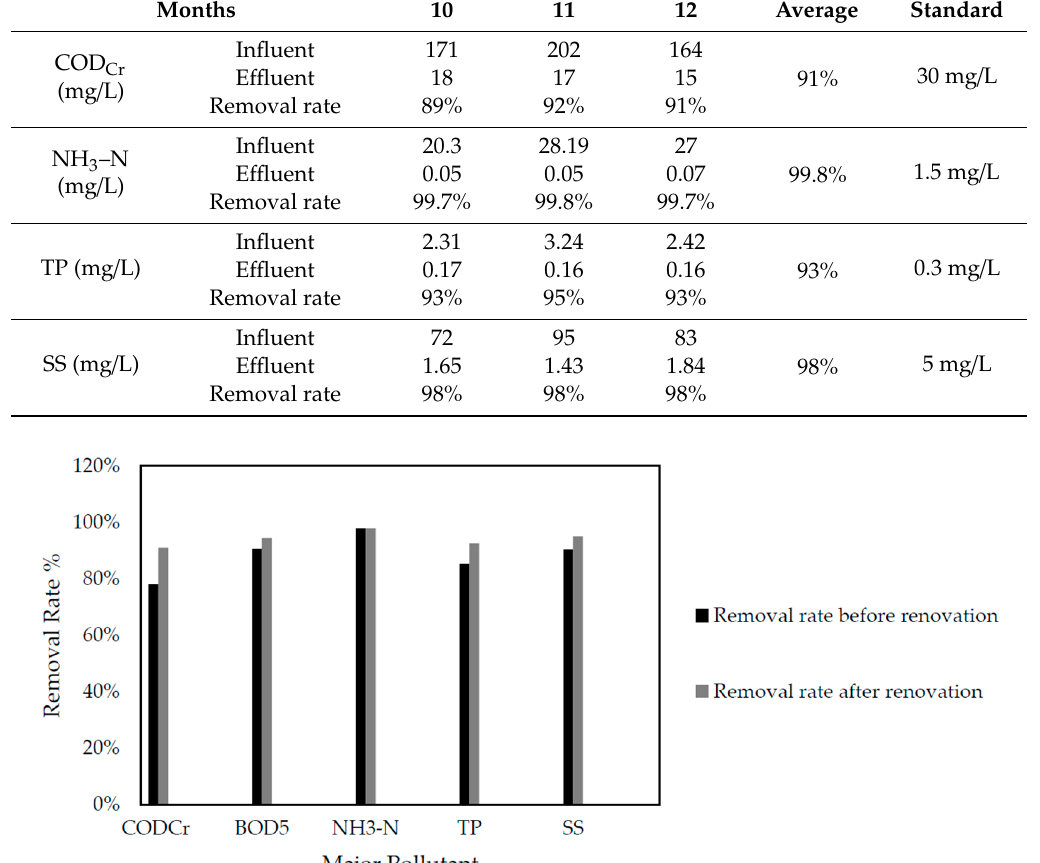
Figure 3. Removal rate of the major pollutants before and after the plant renovation, as well as the comparison of effluent water quality with the new discharge standards.